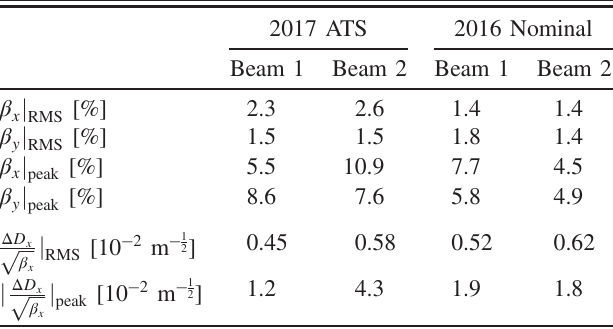
TABLE I. Comparison of linear optics quality obtained with flat orbit for the 2017 ATS optics at β (cid:1) ¼ 0 . 4 m, to that obtained with flat orbit in 2016 for the nominal 0.4 m optics. Values for 2016 were taken from [7].